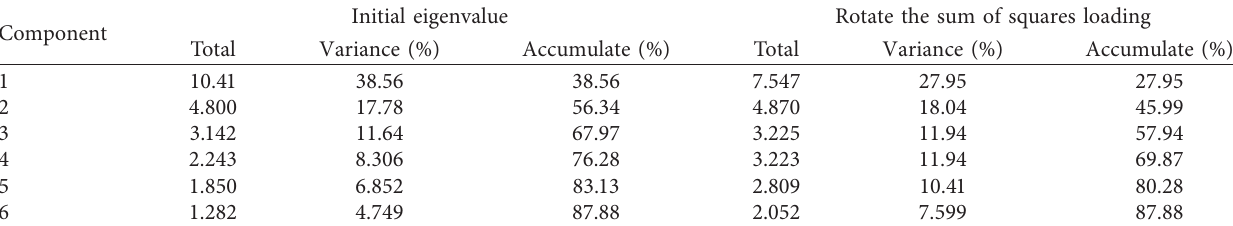
Table 8: Results of principal component analysis.